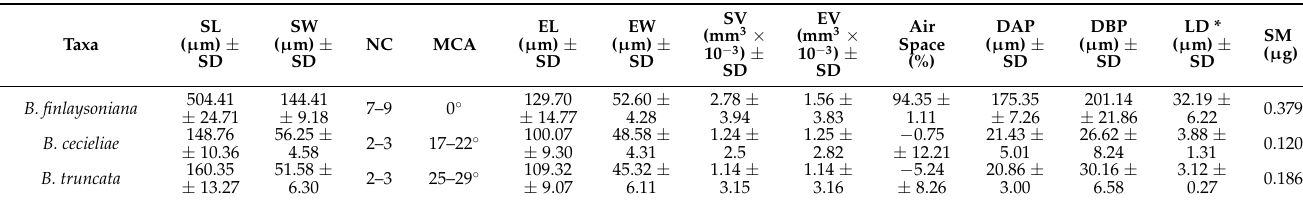
Table 3. Average values and standard deviation of quantitative data in the seeds of the studied species of Bromheadia : seed length (SL), seed width (SW), number of cells (NC), medial cell angle (MCA), embryo length (EL), embryo width (EW), seed volume (SV), embryo volume (EV), percent ‐ age of free air space, distance to the apical pole (DAP), distance to the basal pole (DBP), lateral dis ‐ tance (LD), seed mass (SM). The seed and embryo volumes, and the percentage of free air space were calculated following the described method [2,3].